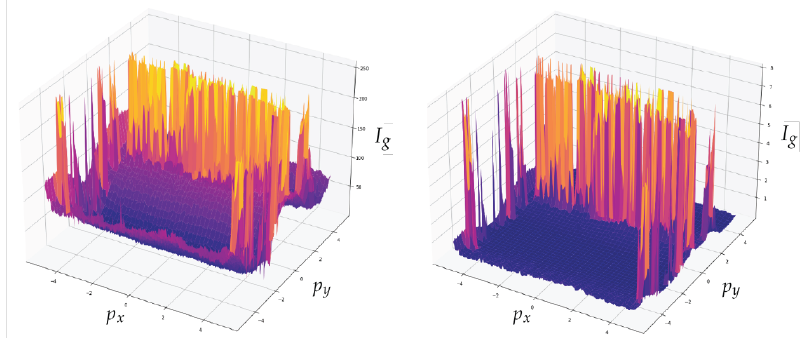
Figure 15. Comparison between the input image and the output of the convolutional denoising autoencoder model, where p x is the position of the horizontal pixel, p y is the position of the vertical pixel and I g is the grayscale intensity of the